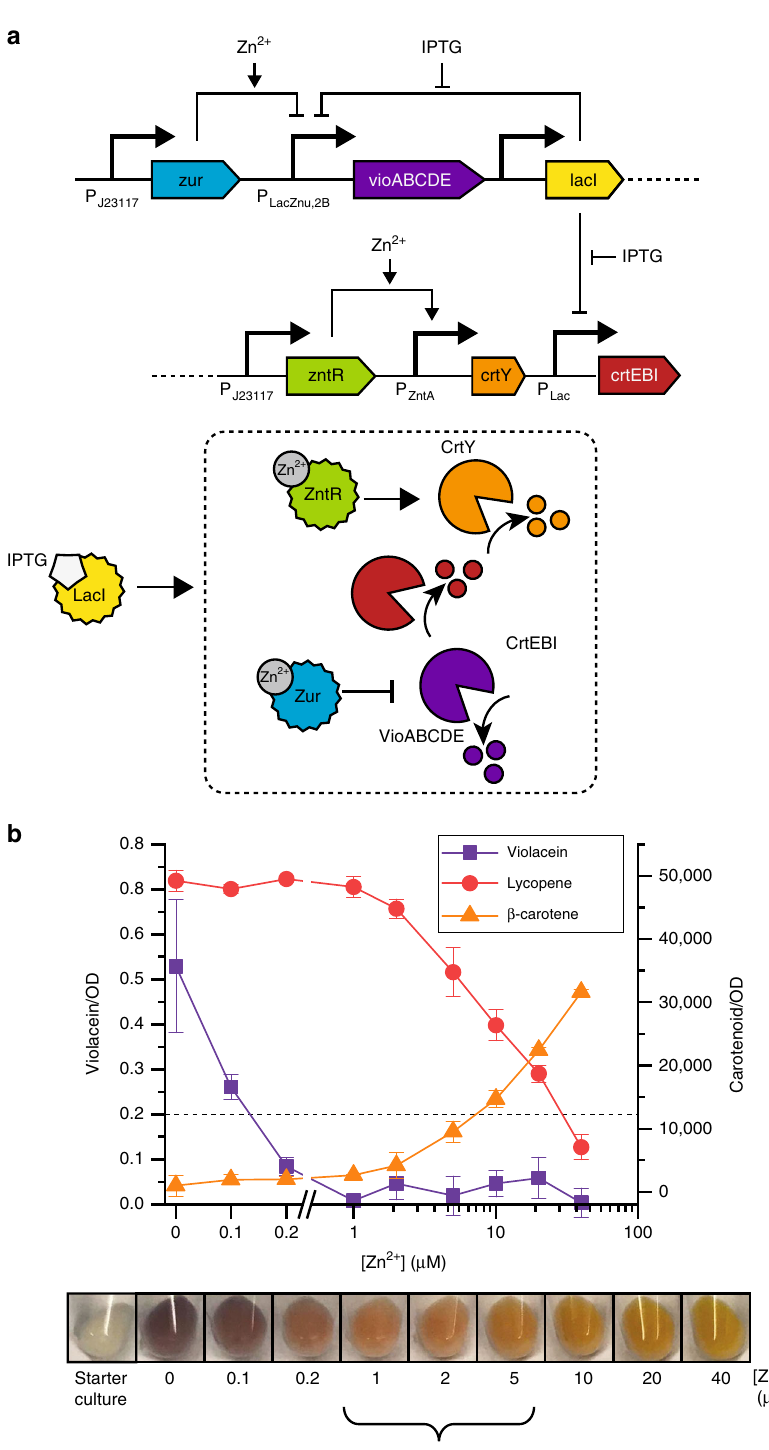
(Supplementary Table 3). Fluorescent protein